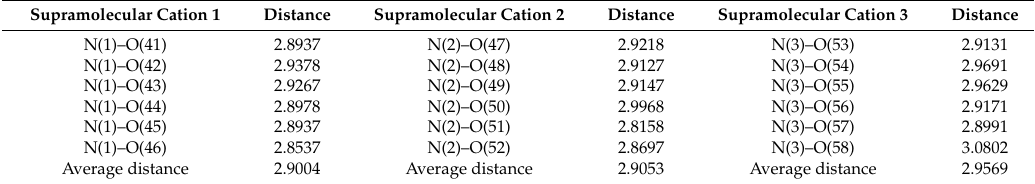
Table 3. H-Bond distances (Å) between the N and O atoms in the supramolecular cation of Crystal 2 . Supramolecular Cation 1